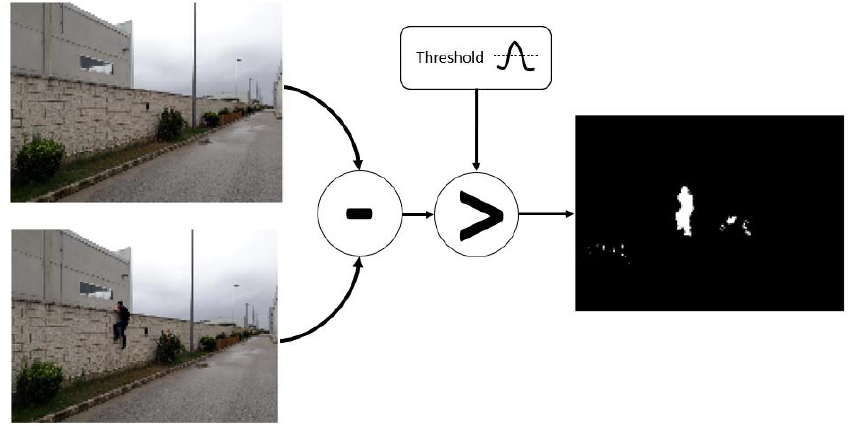
Figure 15. Image detection — preprocessing.